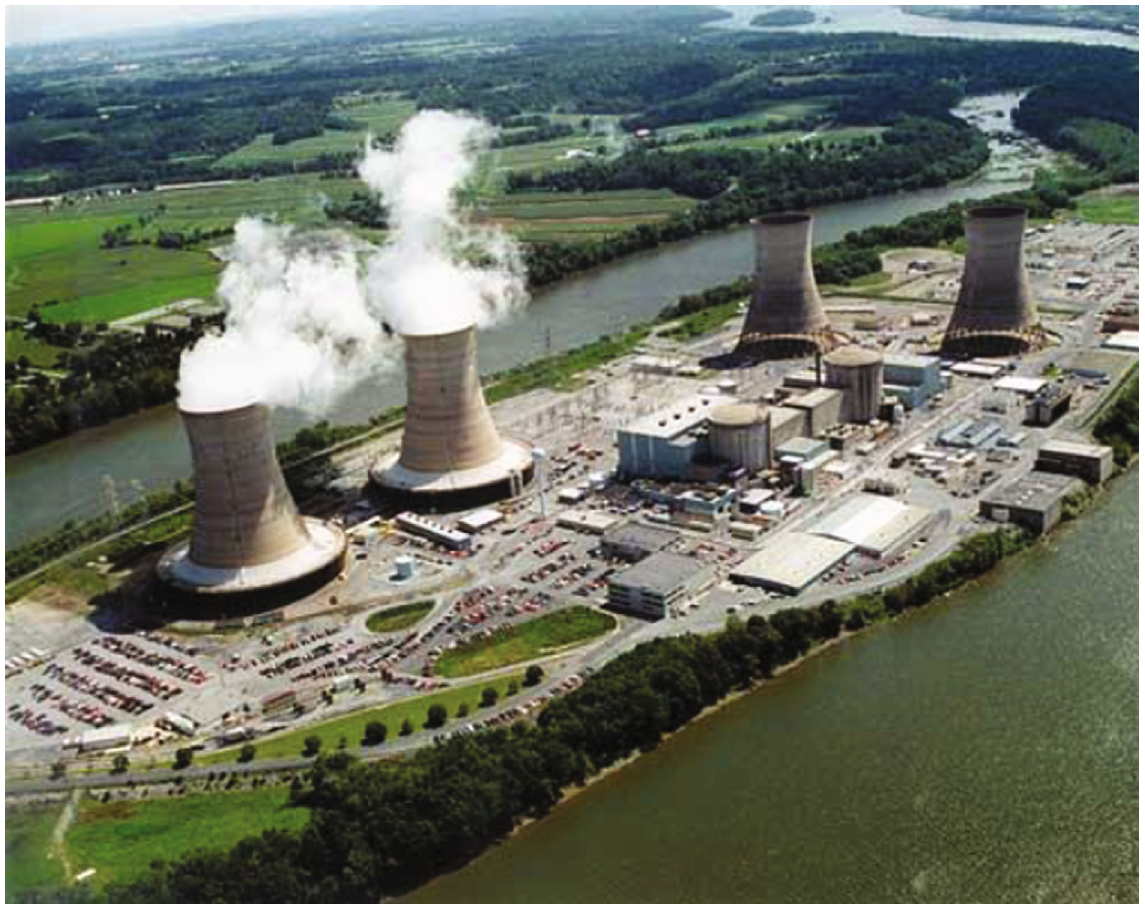
Figure 3: A typical appearance of a nuclear power plant (source: